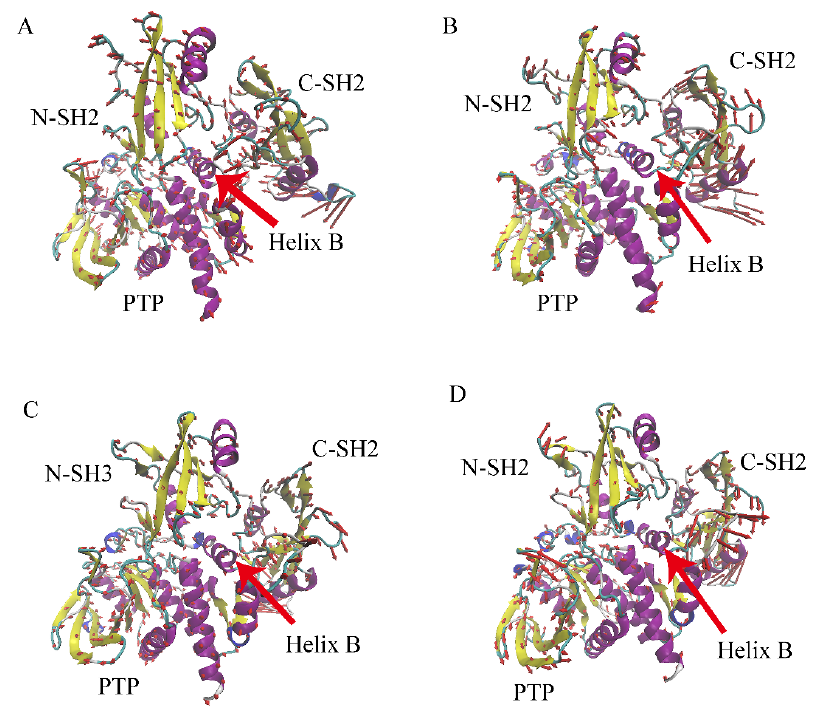
and system EPIYA-C-DUAL ( D Figure 8. The porcupine plots of system SHP2 ( A ), system EPIYA-D-N ( B ), system EPIYA-C-N ( C ), and system EPIYA-C- DUAL ( D ).